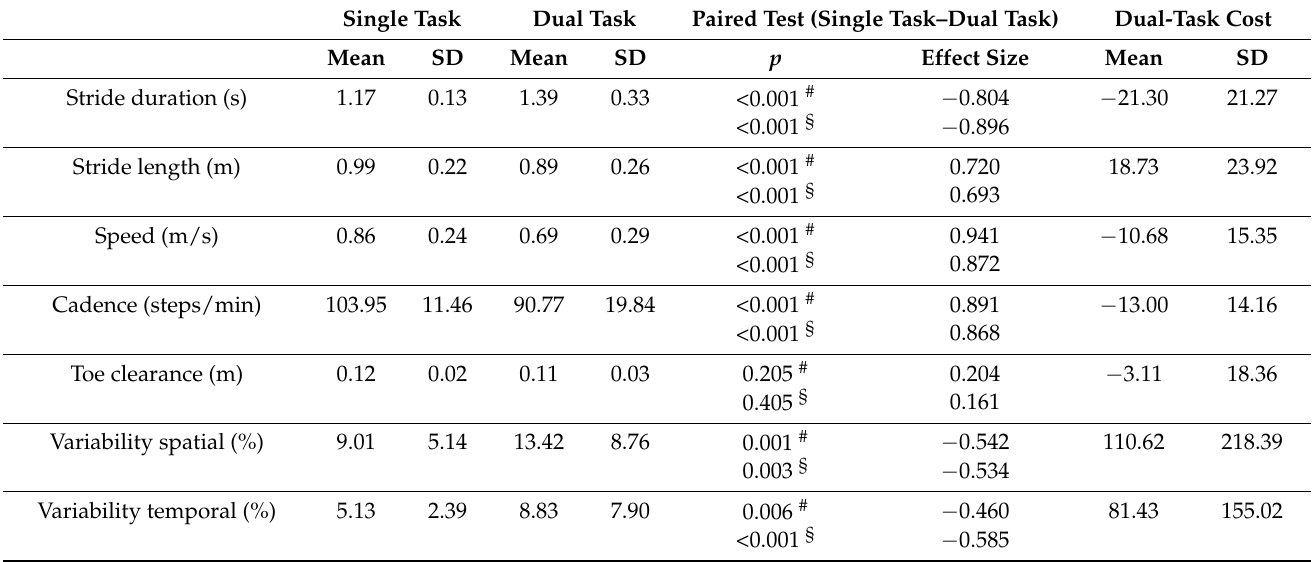
Table 2. Descriptive Statistics for gait measures (single task, dual task) and dual-task cost. Single Task Dual Task Paired Test (Single Task–Dual